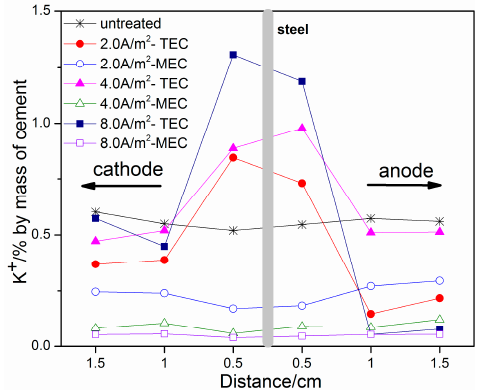
Figure 9. Concentrations of K + ions as a function of location (untreated, after the TEC treatment and the MEC treatment).